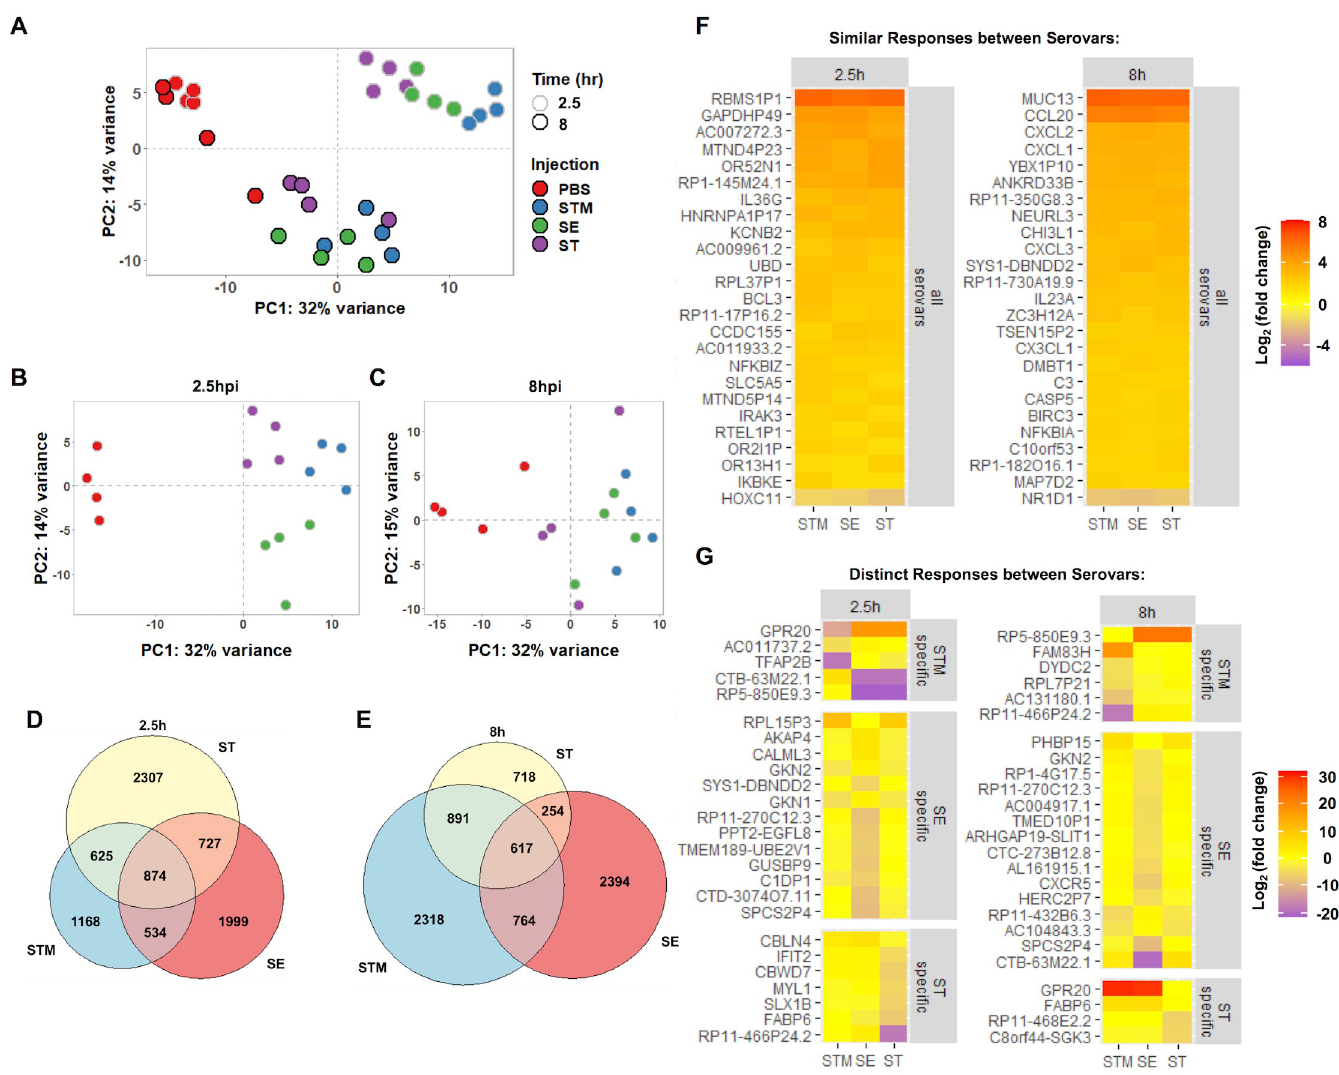
Fig 2. Changes in HIO gene expression are driven by both serovar and time post infection. (A) Principal component analysis of HIOs microinjected with 10 5 CFU of the indicated Salmonella serovars. Each circle represents a biological replicate of a pool of five HIOs. (B and C) Principal component analysis of each time point 2.5h (B) and 8h (C). (D and E) Euler diagram comparison of gene expression changes in each condition relative to PBS at 2.5h (D) and 8h (E) post infection. Genes were filtered by P value < 0.05. (F and G) Heatmaps depicting conserved responses between serovars (F) and distinct responses between serovars (G) based on significant genes sorted by greatest standard deviation between conditions of log 2 (fold change) compared to PBS